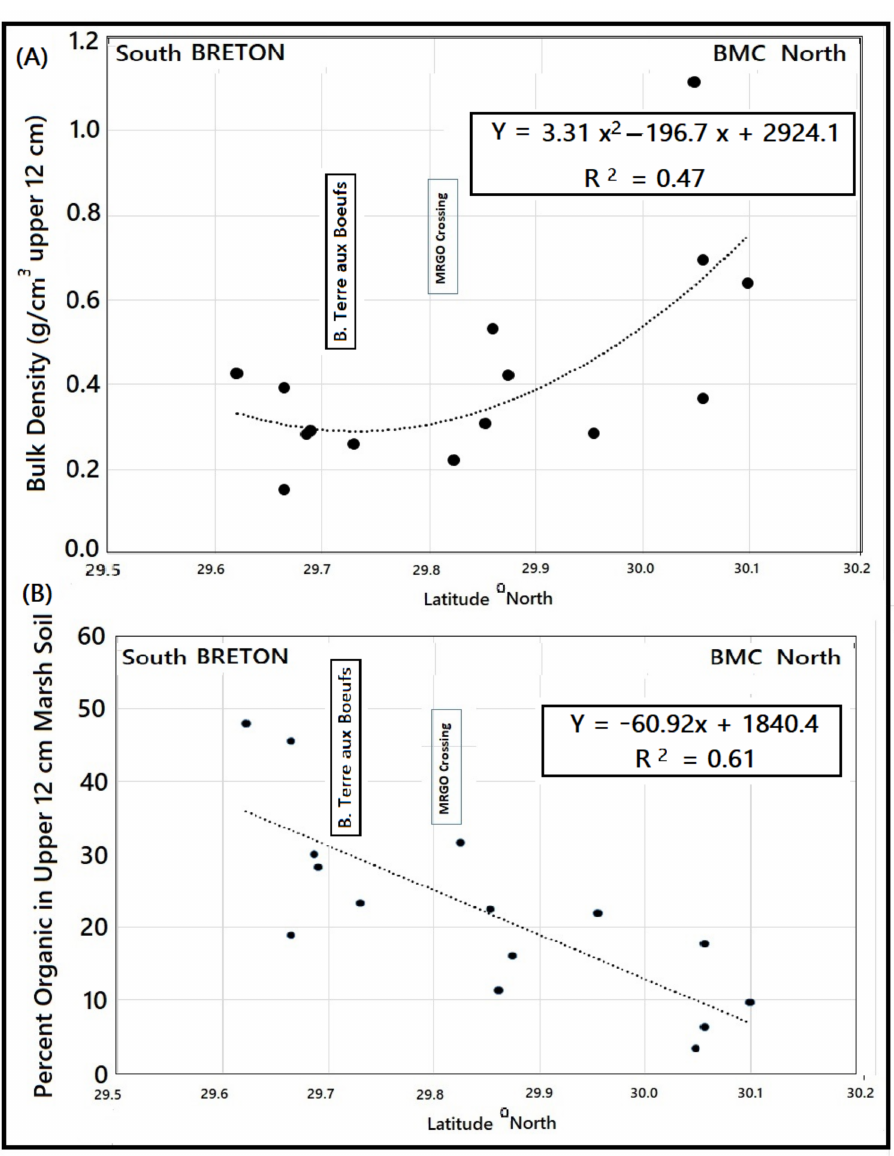
Figure 11. Latitudinal distribution of ( A ) Bulk Density, and ( B ) % Organic Matter on CRMS Transect (Figure 3, Table